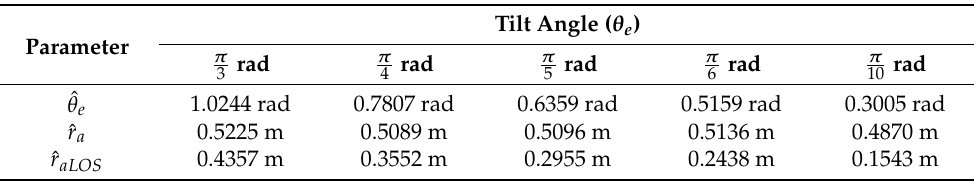
Table 6. The comparison of parameters extraction ability between the monostatic radar and the proposed method.